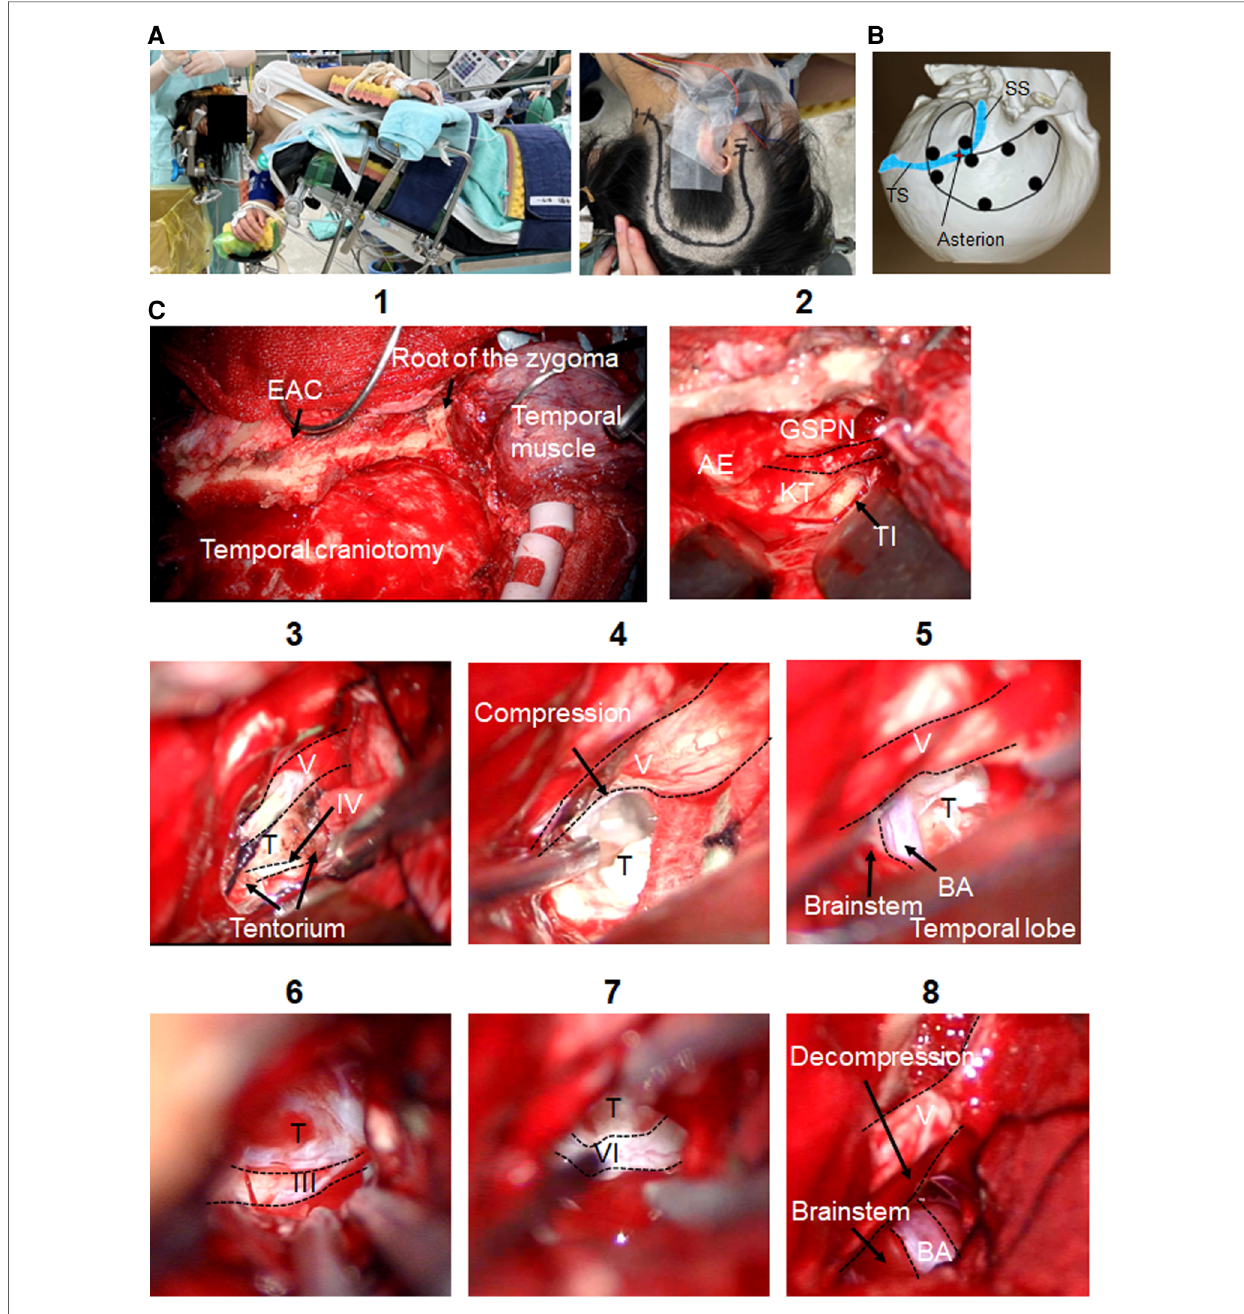
FIGURE 2 Intraoperative fi ndings of the ATP. Microsurgical maneuvers of the ATP are shown. ( A ) Skin incision and patient ’ s position (Park bench) are shown. ( B ) Burr- hole placement for the one-piece temporal-suboccipital craniotomy is shown. ( C ) Surgical fi eld of the ATP is shown (1). The MCF dura is elevated toward the petrous ridge. The middle meningeal artery is coagulated and divided. After the GSPN is preserved, the landmarks for drilling Kawase ’ s quadrangle are identi fi ed (2). The tentorium is opened exposing the trigeminal nerve superior to petroclival tumor. Trochlear nerve is exposed coursing over tumor before entering tentorium (3). Trigeminal nerve is compressed by tumor (4). Tumor removal of the prepontine cistern and supratentorial region is done. BA, brainstem (5), and oculomotor nerve (6) are identi fi ed. The lower limit of this exposure is the abducens nerve (7). Trigeminal nerve decompression is done (8). ATP, anterior transpetrosal approach; MCF, middle cranial fossa; AE, arcuate eminence; BA, basilar artery; EAC, external auditory canal; GSPN, greater super fi cial petrosal nerve; KT, Kawase ’ s triangle; T, tumor; TI, trigeminal impression; TS, transverse sinus; SS, sigmoid